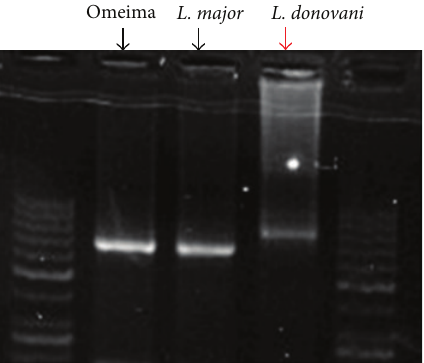
Figure 14: PCR of patient no. 4 (Omeima) showing L. major band with L. major and L. donovani